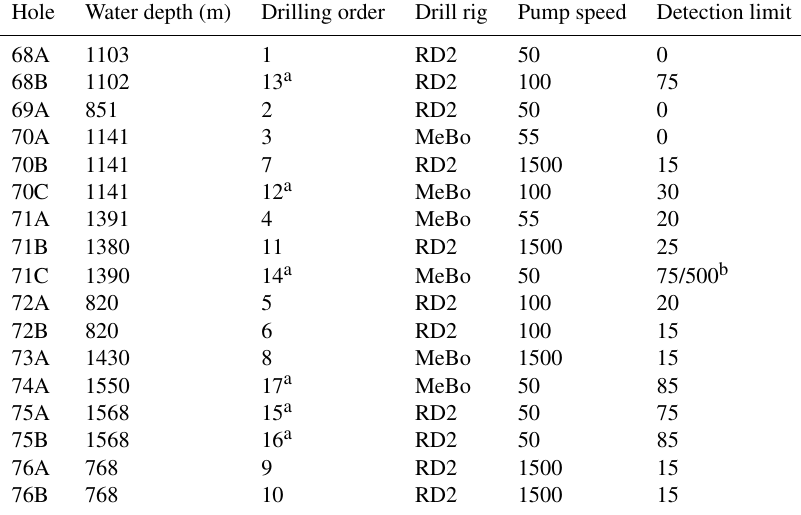
Table 1. Summary of PFC tracer system operations during IODP Expedition 357 organized by hole, including water depth in meters, drilling sequence order, drill rig, speed of delivery pump (revolutions per minute) and laboratory lower detection limits (in pgcm − 3 ) for the quantification method. a by drilling order number indicates deployments after the tracer delivery pump modification as described in the text. Two different detection limits for Hole 71C samples (indicated by b ) indicates two different labs where samples were collected, with the lower value indicating the blank for the lab where sensor package and liner fluid samples were collected. Pump speeds previously reported elsewhere (Früh-Green et al.,